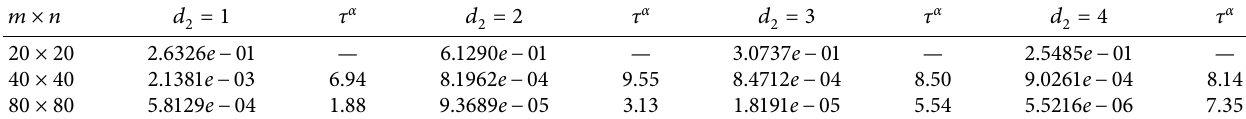
� 7 for Example 2. 1